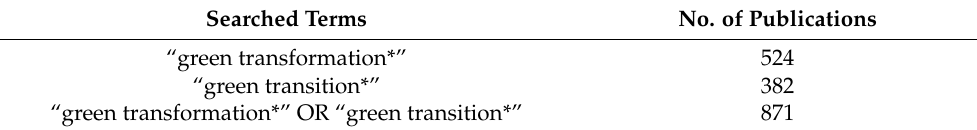
Table 2. Number of papers indexed in the WoS databases, including the indicated keywords.